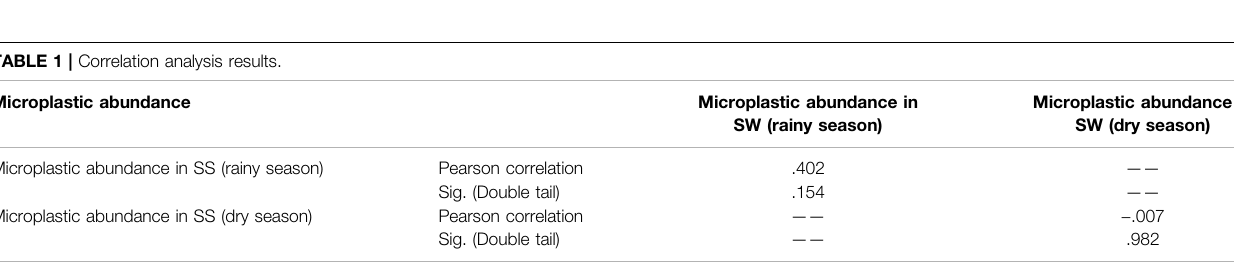
TABLE 1 | Correlation analysis results.